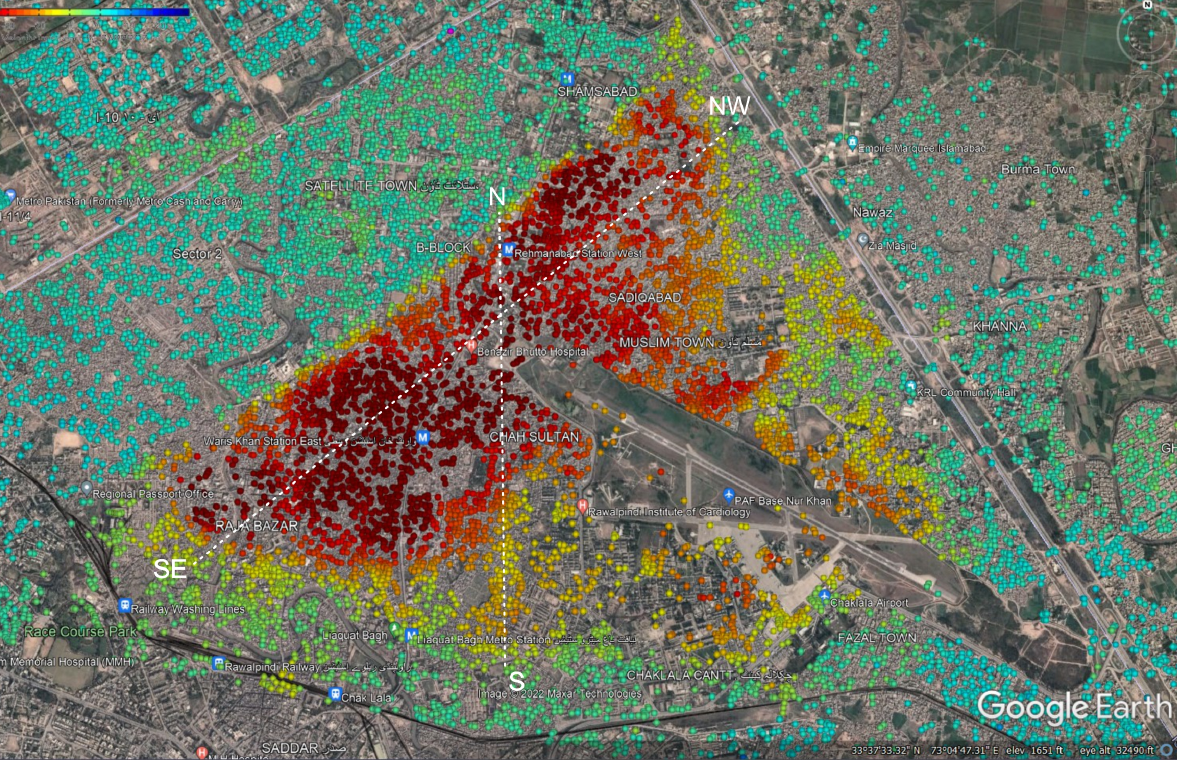
Figure 13. Showing the subsidence profile from North to South and North-West to South-East.